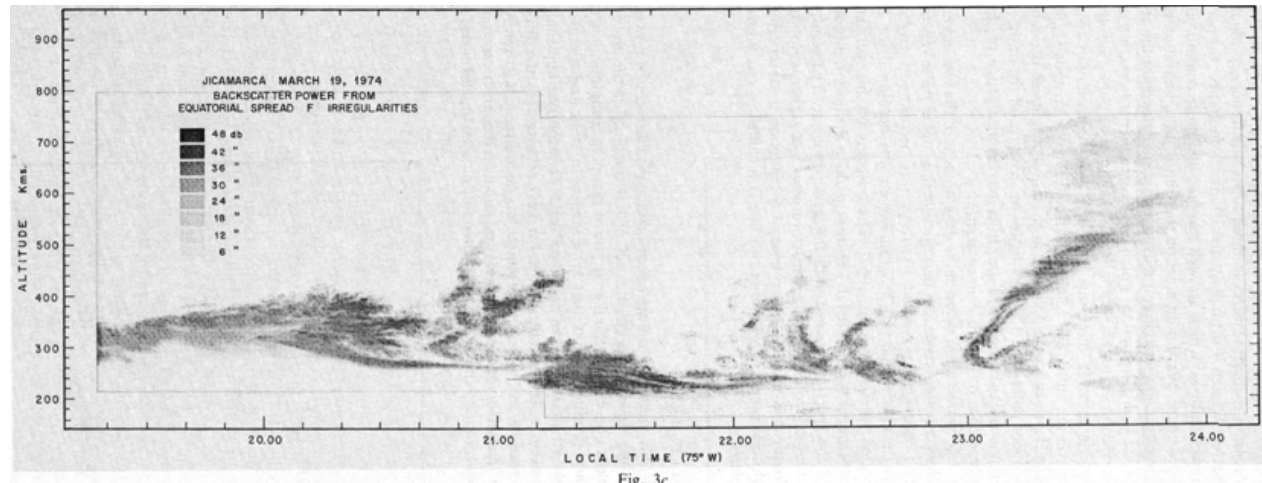
Fig. 7. Range-time-intensity plot of backscattered echoes from Spread F irregularities. The plume starting at 2300h and 300km altitude connected with the 600km irregularities an hour later was the clue to explain the irregularities at gravitational stable altitudes (after Woodman and La Hoz,